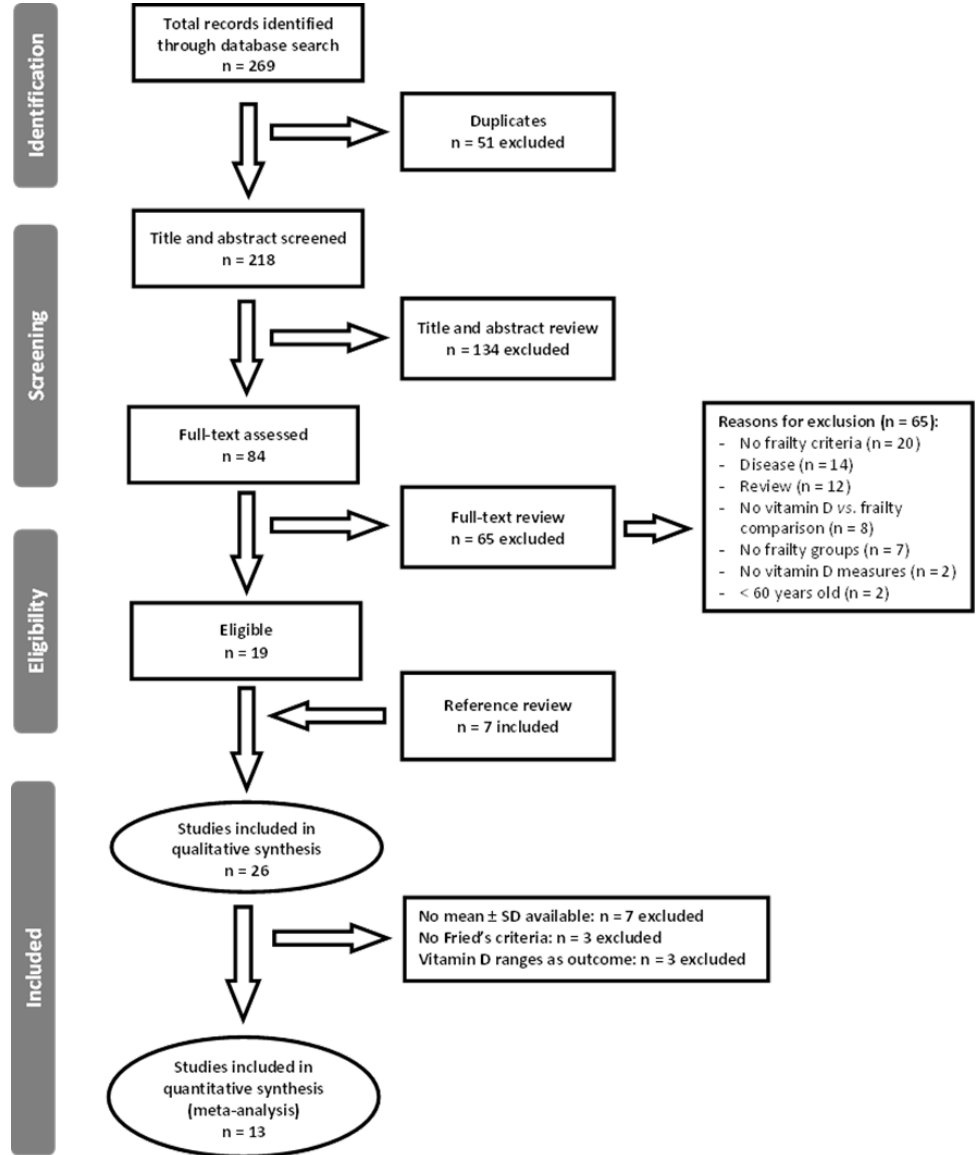
Figure 1. Preferred Reporting Items for Systematic Reviews and Meta-Analyses (PRISMA) flow chart of the study selection process. SD: standard deviation.